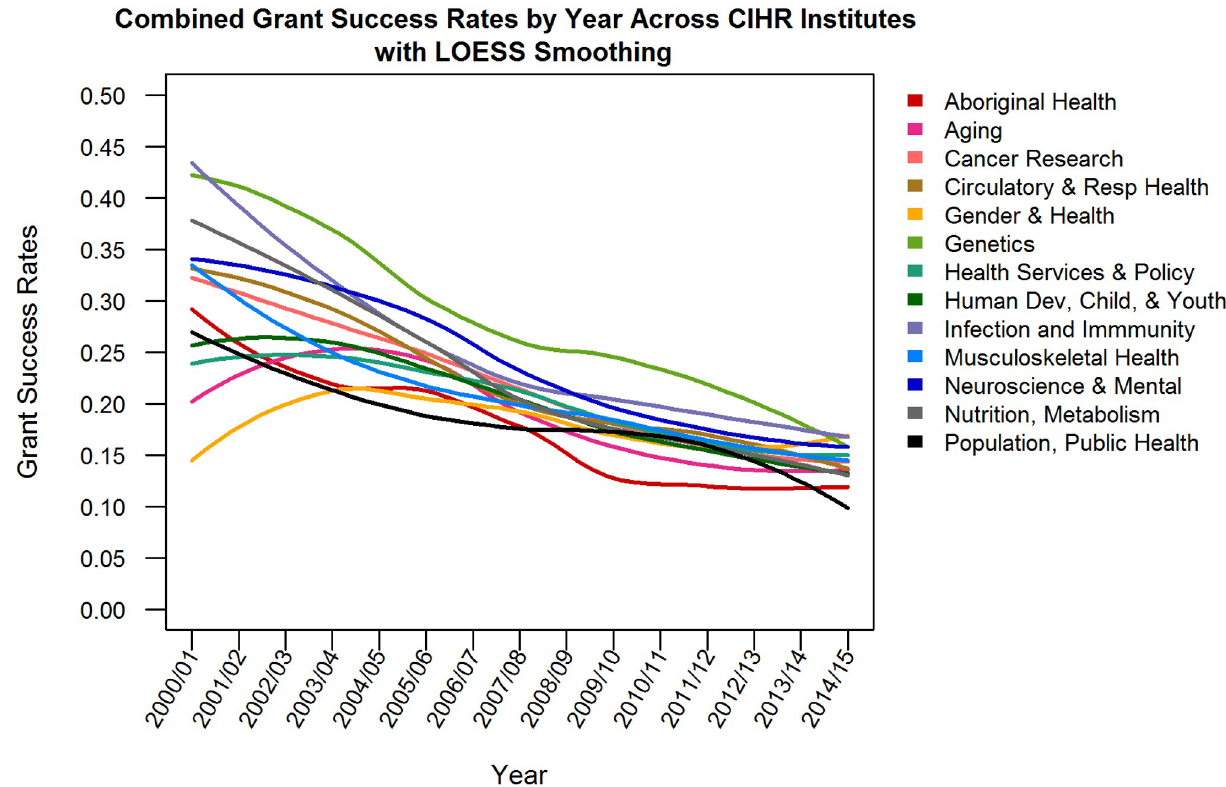
Fig 1. Combined grant success rates by year across CIHR institutes. CIHR, Canadian Institutes of Health Research; LOESS, locally estimated scatterplot smoothing; SD, standard deviation.